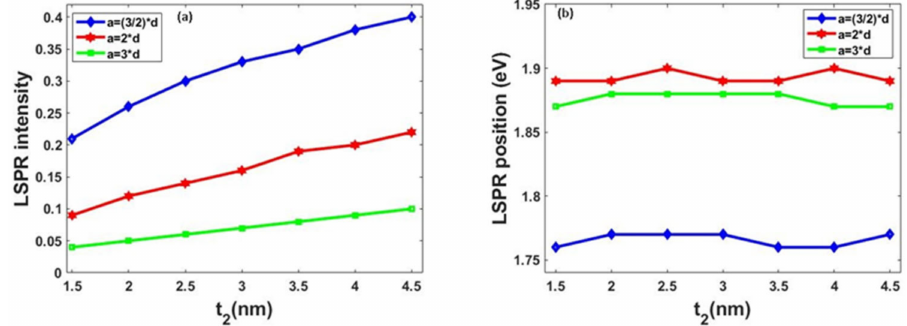
Figure 8. ( a ) Absorbance changes; ( b ) Energy changes over t 2 when t 2 = 1.5 nm–4.5